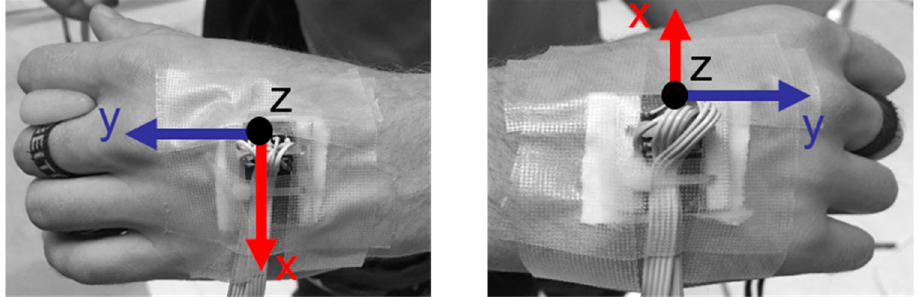
Figure 1. Position of the sensor on the hands of one subject. The origin of the sensor was always at the level of the phalanx proximalis of the digitus manus III.